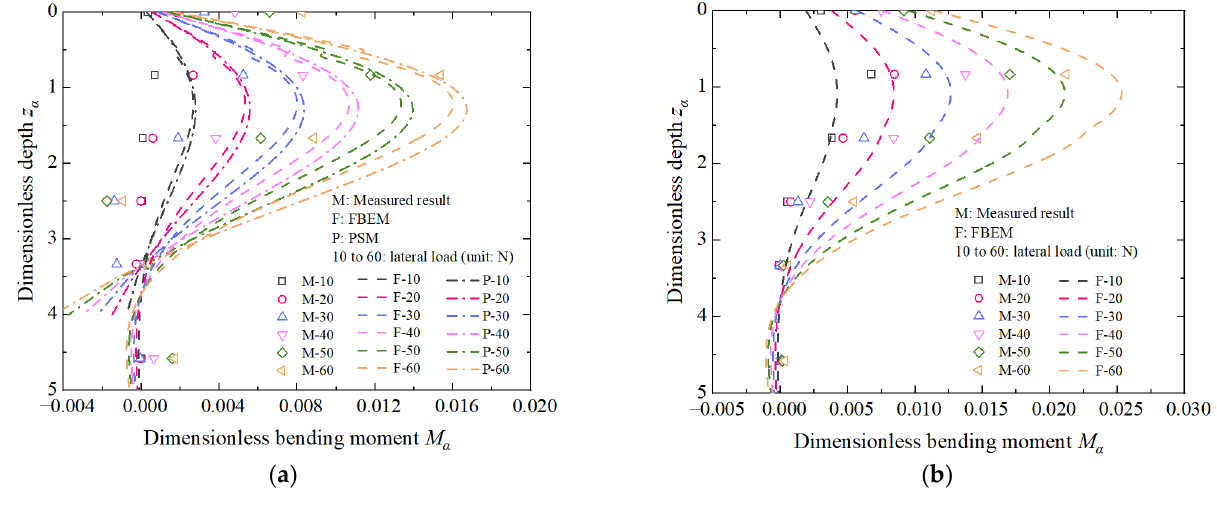
Figure 8. Comparisons of dimensionless bending moment profiles in lateral static loading tests. ( a ) in sloping ground; ( b ) in sloping